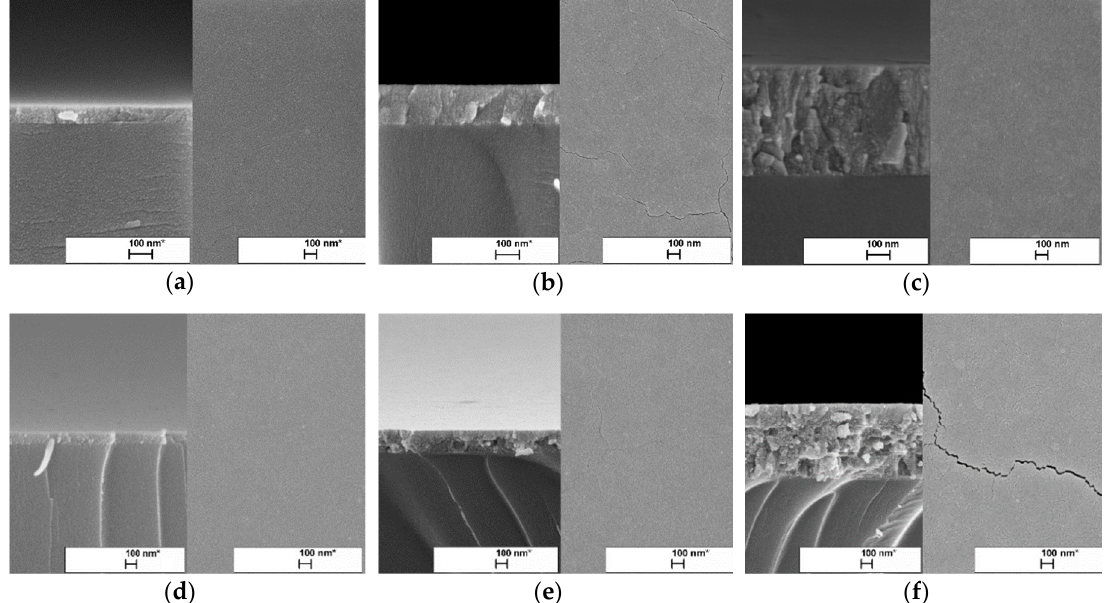
Figure 1. Surface and cross-sectional SEM images of TiO 2 thin films prepared from di ff erent solution concentrations and spray cycles. TiO 2 thin films deposited from 0.1 M solution with the number of spray cycles: ( a ) 2, ( b ) 6, and ( c ) 15. TiO 2 thin films deposited from 0.2 M solution with the number of cycles: ( d ) 2, ( e ) 6, and ( f ) 15.